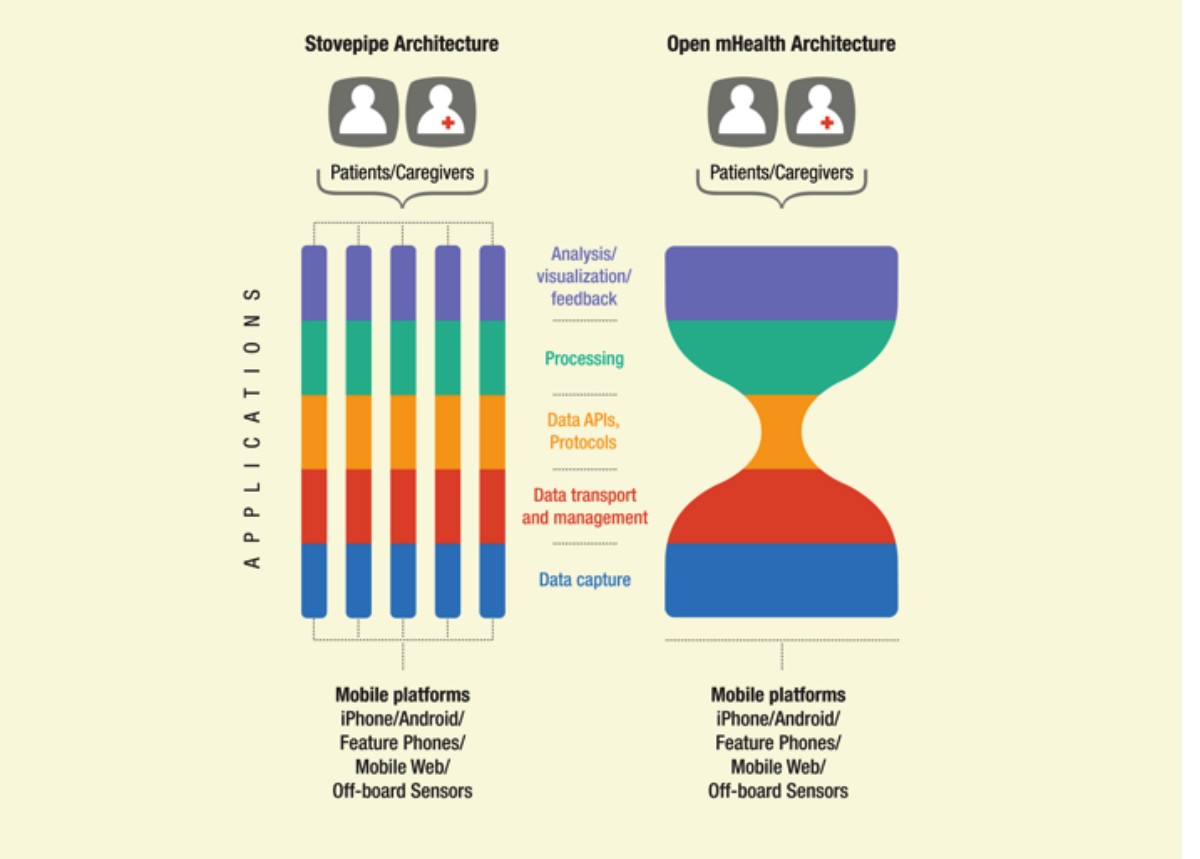
Figure 1. Stovepipe versus open architectures: mHealth apps (left) are built independently with little sharing of data, methods, or learning. In contrast, the Internet has an hourglass architecture (right), in which a common protocol, transmission control protocol/Internet protocol (TCP/IP), acts as a simple point of commonality at the narrow waist that allows innovation to flourish through open application programming interfaces (APIs) both above and below the waist. Open mHealth aims to catalyze the mHealth ecosystem from a siloed architecture to an hourglass architecture to increase the scale and effectiveness of